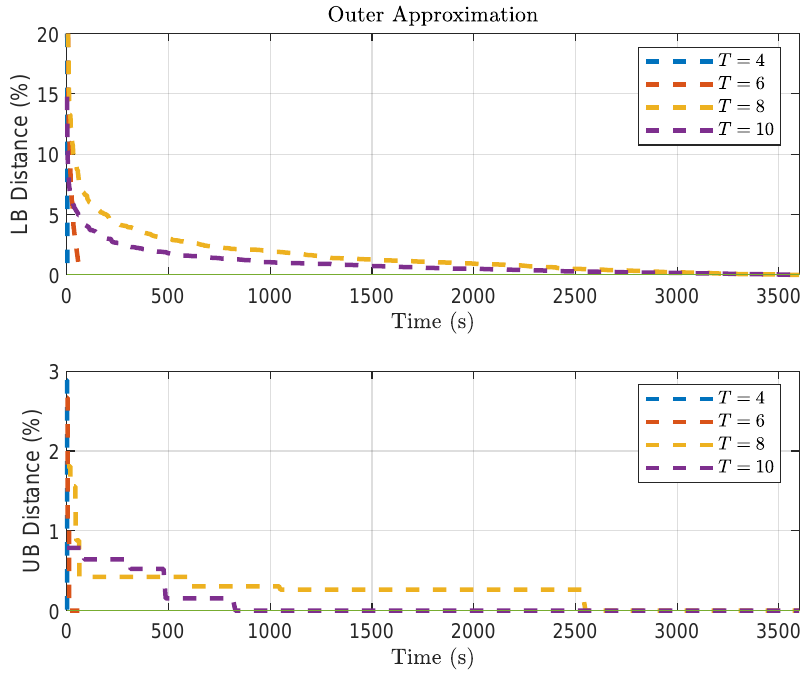
Figure 5. Trajectory of the bounds in Outer Approximation solution, for problem M = 8, considering a varying length of T for the prediction